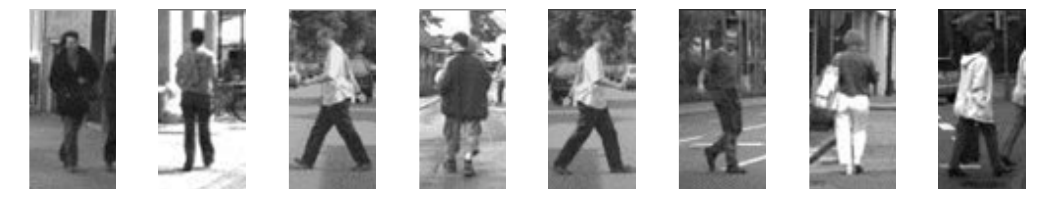
Figure 5. Some samples of Daimler dataset.